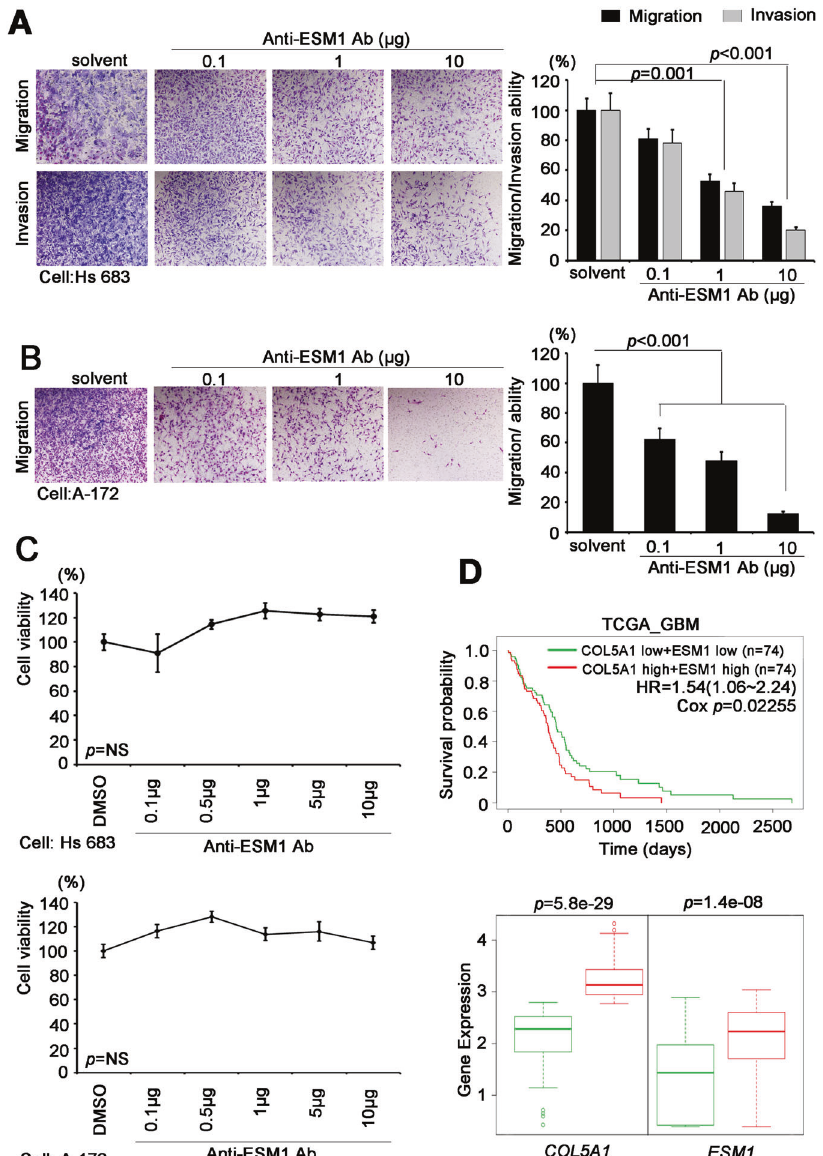
Fig. 6 ESM1 acts as the coordinator of the COL5A1-induced phenotype in GBM. A Migration and invasion abilities and quantitative results of the ESM1-neutralizing antibody in Hs 683 cells. B Migration ability and quantitative results of the ESM1-neutralizing antibody in A-172 cells. C The viability of Hs 683 and A-172 cells with or without ESM1-neutralizing antibody treatment. D Kaplan – Meier